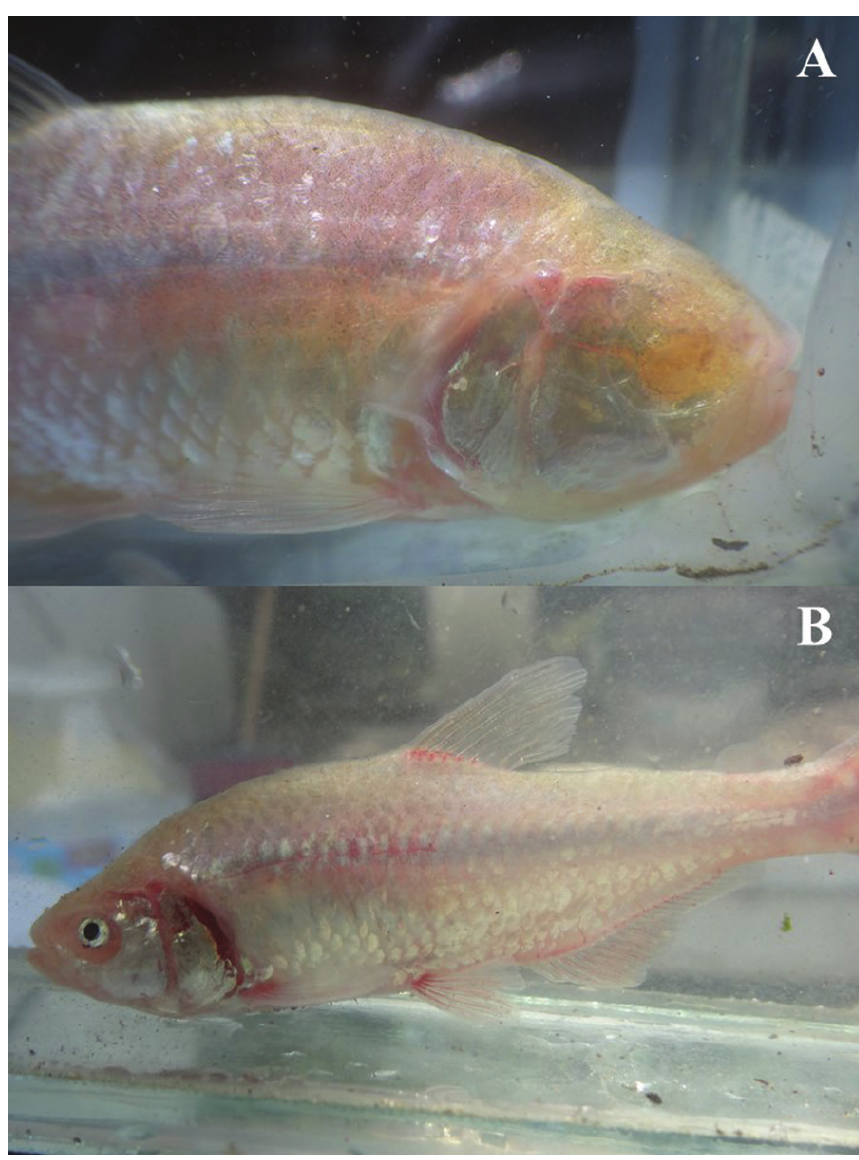
Figure 4. Variability in the correlation between eye and pigment may suggest introgression between the surface morph and the cave morph as evidenced by the presence of individuals that are highly depig- mented, and without eyes ( A ) or individuals that are also highly depigmented but with eyes ( B ). For the other combinations of eye and pigment see Figure